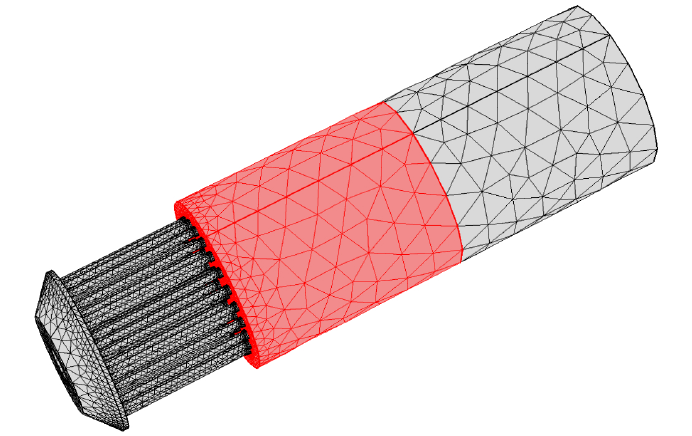
Figure 2. FEM model of BKD combustor. The flame region is assmued and represented by the red block.